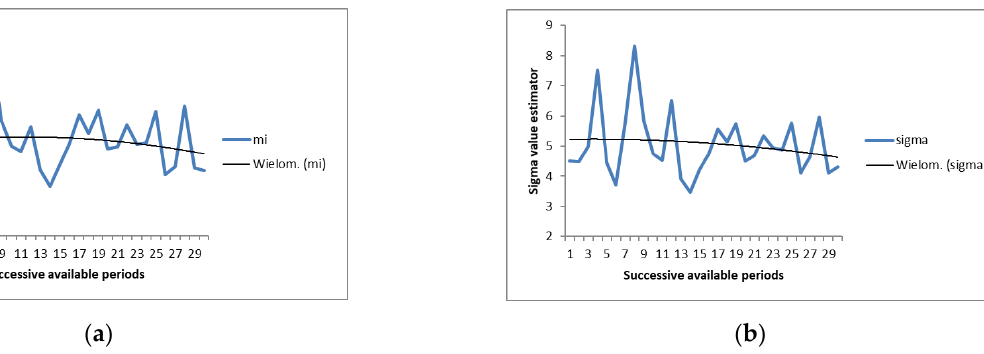
Figure 5. Values of estimators together with the fitted functions for: ( a ) m 1 ,…, m 30 ; ( b ) σ 1 ,…, σ 30 . Table 4. Calculation of distribution parameters m̂ 31 , σ ̂ 31 describing the disassembly times of the joint predicted for Rec .